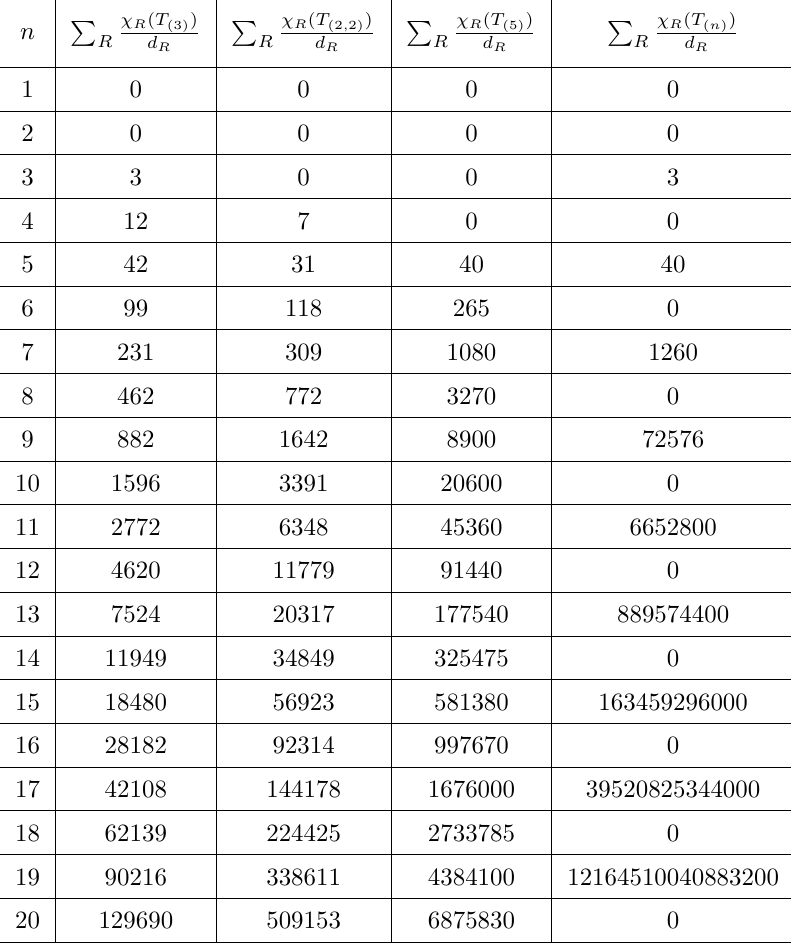
Table 2 . Table listing the sequences of sums of normalized characters of T p , where p label conjugacy classes of the symmetric group S . We consider the conjugacy classes p = (3) , (2 , 2) , (5) and ( n ) n for n = 1 up to n = 20 . The final column shows the normalized character for T normalized character for T for n = 5 and so on. These quantities for even n are all (5)